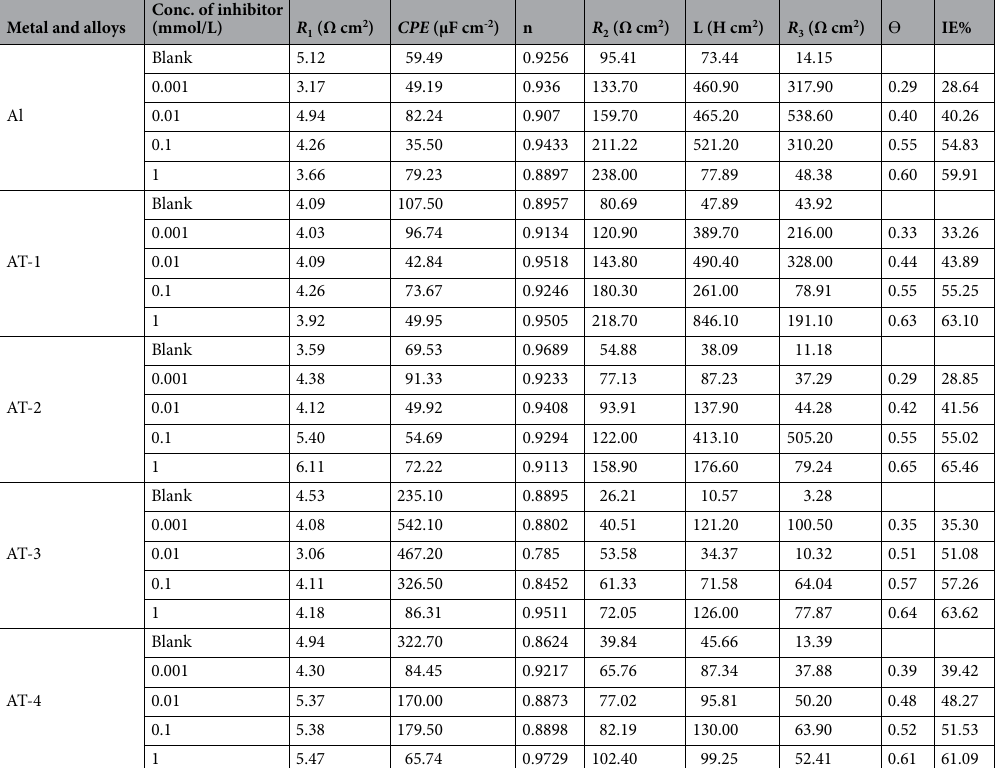
Table 7. Electrochemical parameters and inhibition efficiencies derived from EIS for Al, AT-1, AT-2, AT-3, and AT-4 alloys in 0.5 M HCl solution comprising various concentrations of 2-MBT at 25 °C.